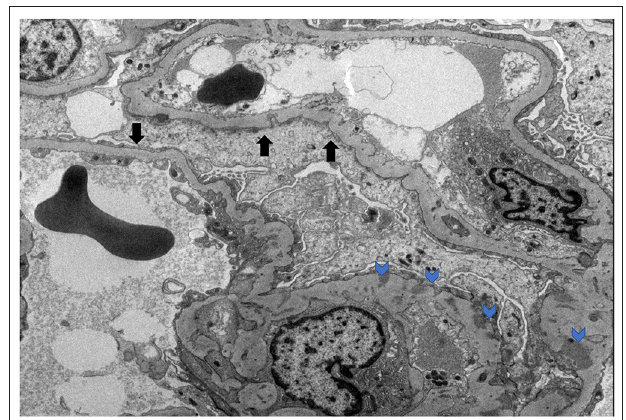
FIGURE 1 | MCD electron microscopy. Black arrows denote podocyte effacement. Blue arrows denote podocyte subendothelial deposits.